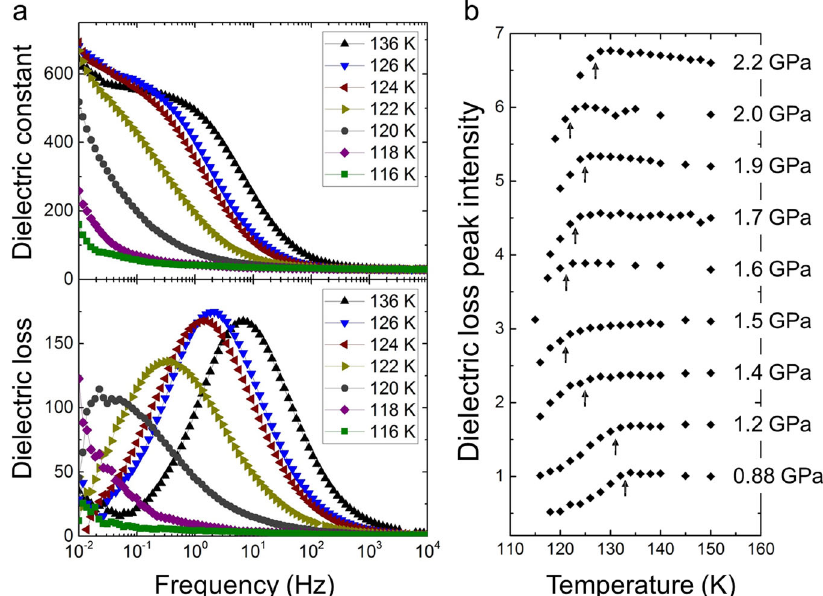
Fig. 2 Temperature dependence of dielectric properties of HCl-doped ice VI and its hydrogen-ordered phases. a Dielectric constant and dielectric loss of HCl-doped ice VI and its hydrogen-ordered phase (ice XIX) obtained at 1.9 GPa upon cooling using an LCR meter (NF corp., ZM2371). The measured frequency was from 3 mHz to 2 MHz. b Temperature dependence of dielectric loss peak intensity of HCl-doped ice VI and its hydrogen-ordered phases obtained in the pressure range 0.88 – 2.2 GPa upon cooling (black diamonds). Each peak intensity of dielectric loss was estimated using a model fi tting for the corresponding dielectric loss spectrum based on the Debye dielectric-relaxation equation (polydispersion type). Under each pressure, peak intensities were normalised by that obtained at the highest temperature. Each plot was shifted by 0.7 with increasing pressure for clarity. In each pressure, the transition temperature whose determination is described in Supplementary Method 2.2 is indicated by black arrows.